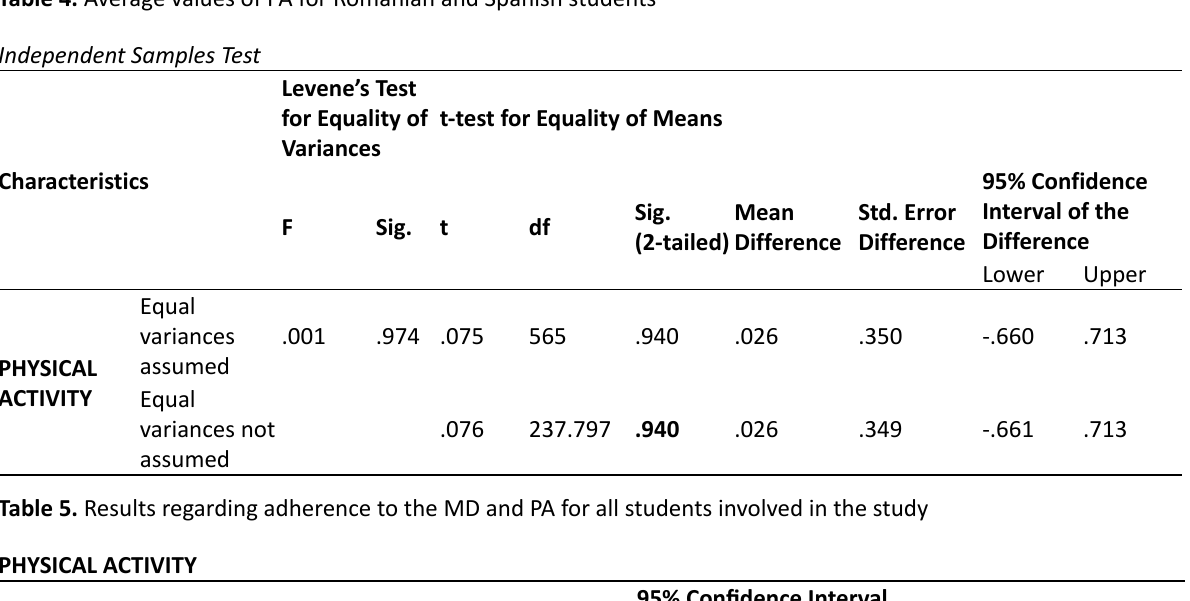
Table 4. Average values of PA for Romanian and Spanish students Independent Samples Test